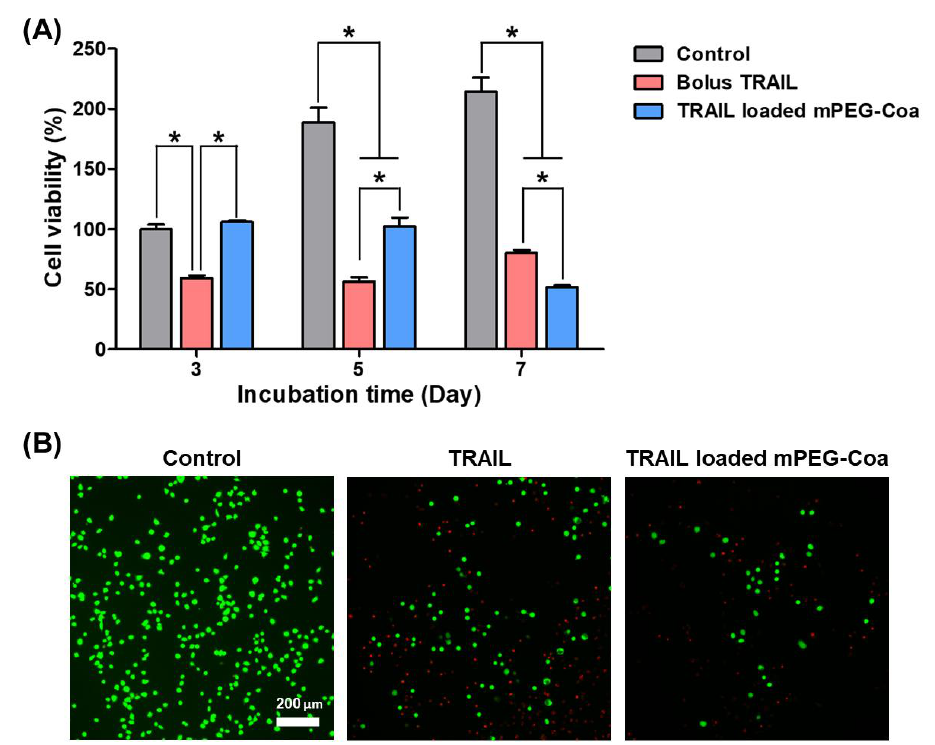
Figure 5. Inhibition of colon cancer recurrence via mPEG-Coa-mediated TRAIL delivery. ( A ) Via- bility of HCT-116 cells and ( B ) live/dead fluorescence microscope images after 7 days of treatment. (*) indicates that the experimental group is statistically different to indicated experimental groups.